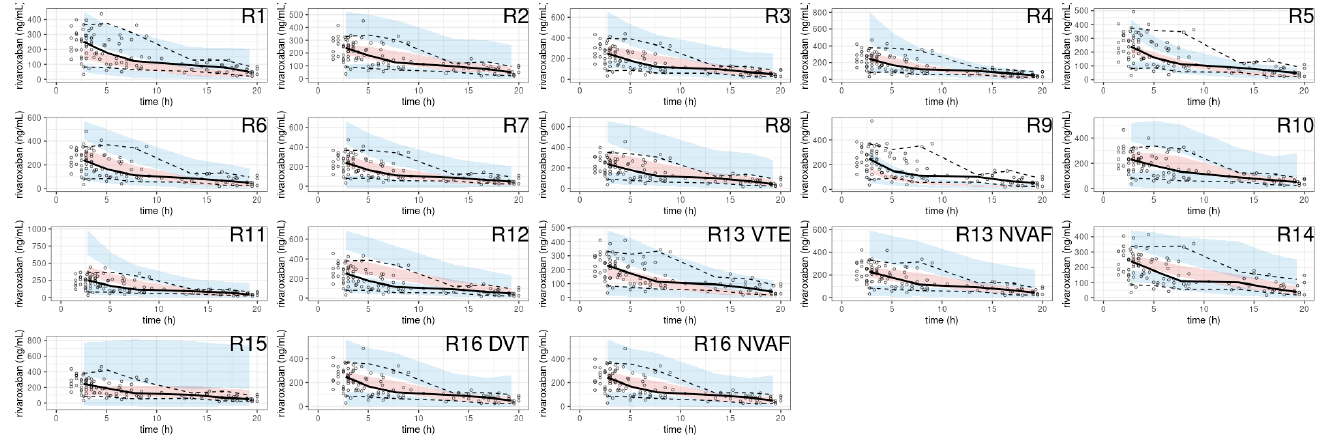
Figure 5. NPDE histograms and QQ plots of apixaban population pharmacokinetic studies applied to the external validation dataset.